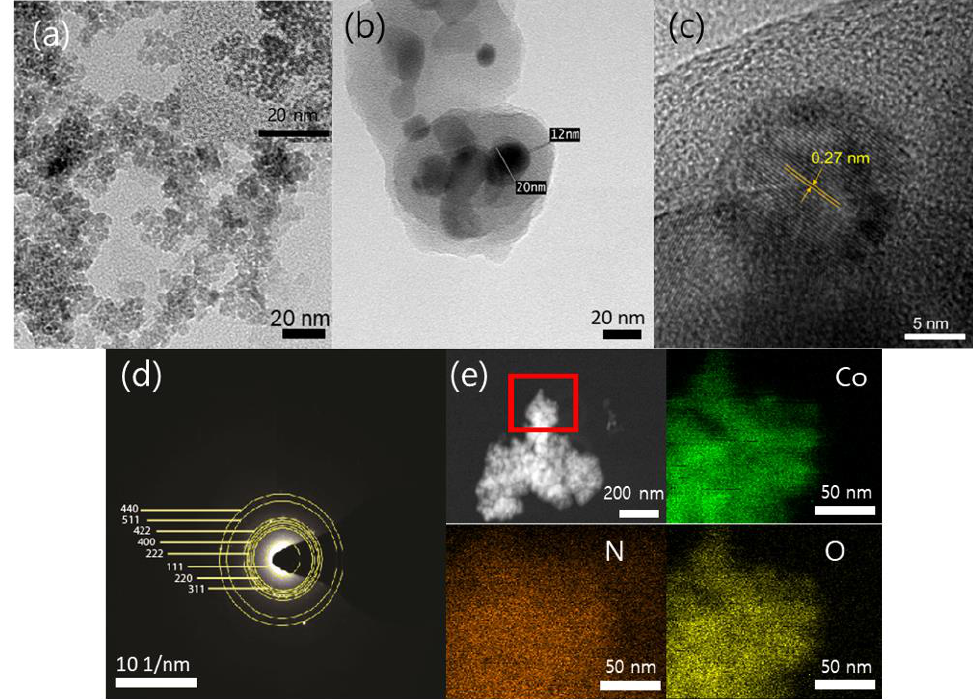
Figure 2. TEM images of ( a ) bare Co 3 O 4 NPs and ( b ) PDA@Co 3 O 4 NPs. PDA@Co 3 O 4 NPs were addi- tionally analyzed by ( c ) HRTEM, ( d ) SAED, and ( e ) EDX mapping images of the selected region (shown as red rectangle).